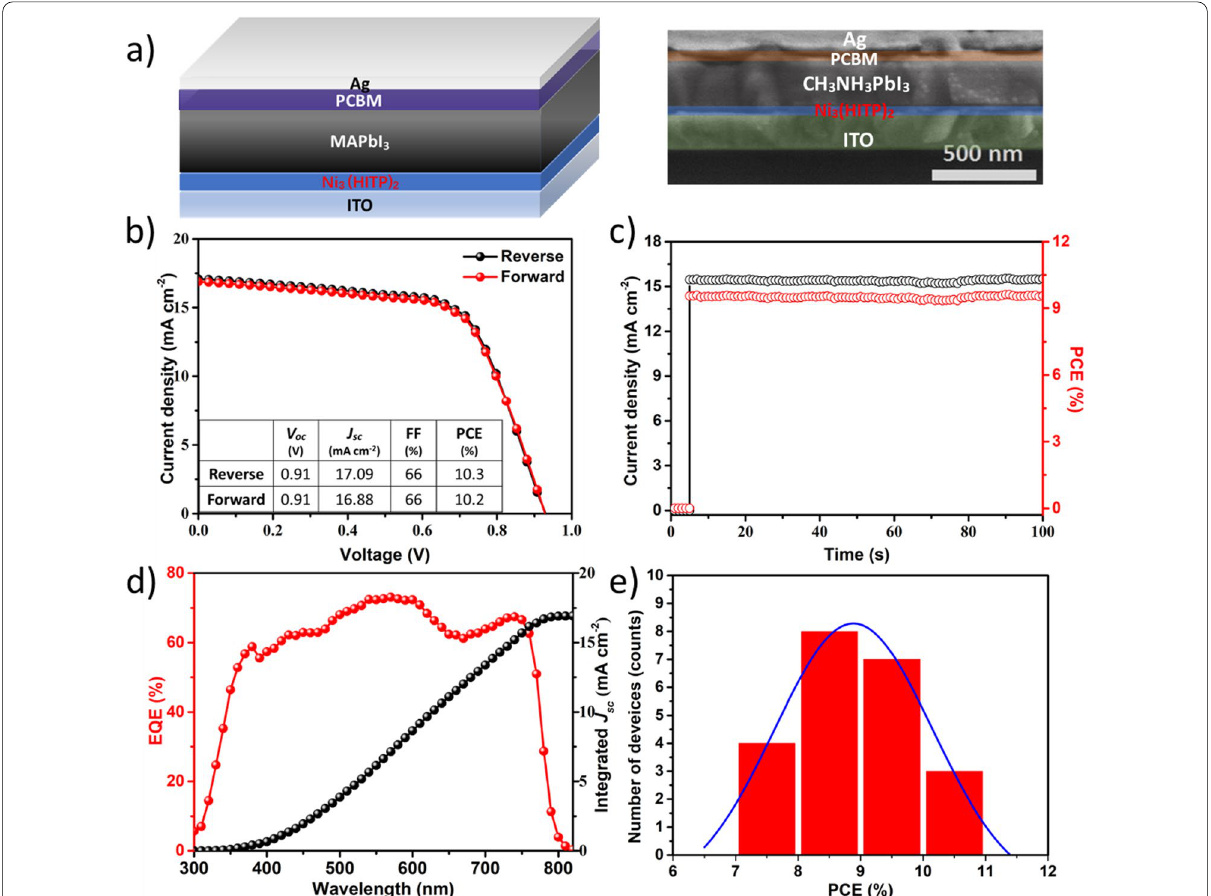
Fig. 5 The characterization of the PSCs. a The device structure and SEM image of cross section; b the J – V curves of the device under forward scan and reverse scan; c steady-state photocurrent (black curve) and output efficiency (red curve) of the device; d EQE and corresponding integrated J sc ; e histogram of PCEs measured from 22